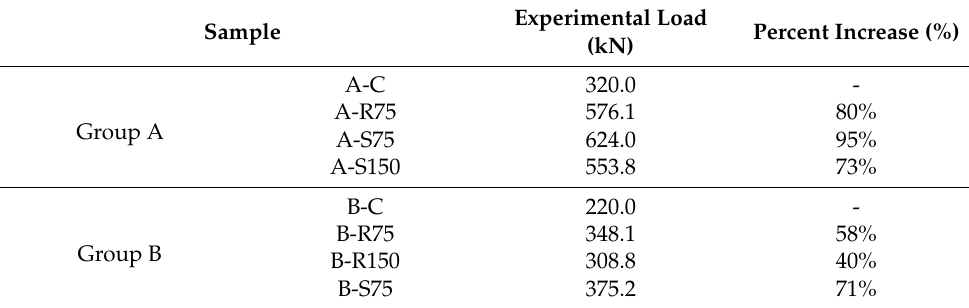
Table 4. Experimental Load Figure 8. Deflection along the beam length.